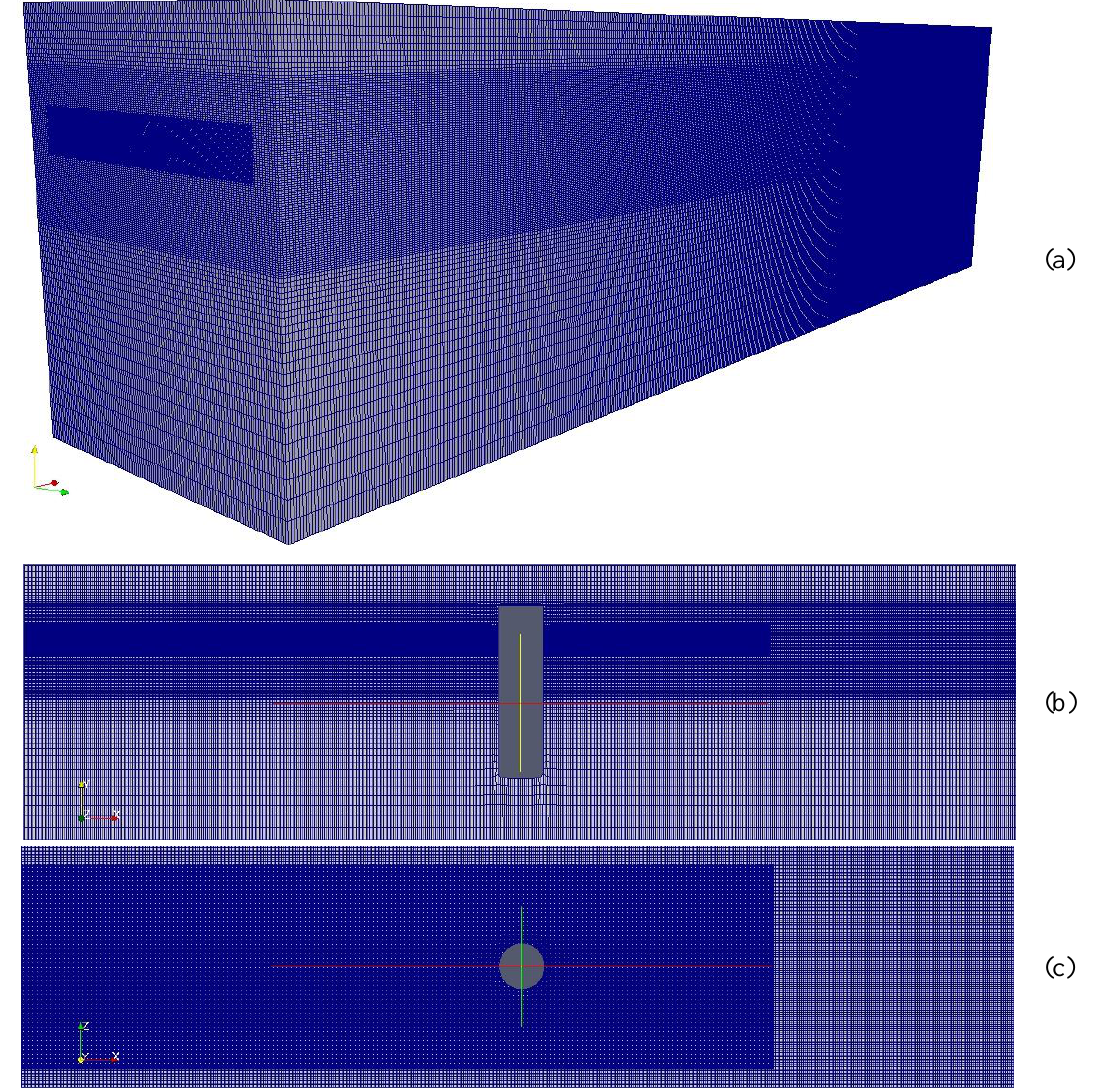
Figure 2. Overall simulation domain for the vertical truncated cylinder ( a ), mesh distribution on the side ( b ) and top ( c ) of the domain.